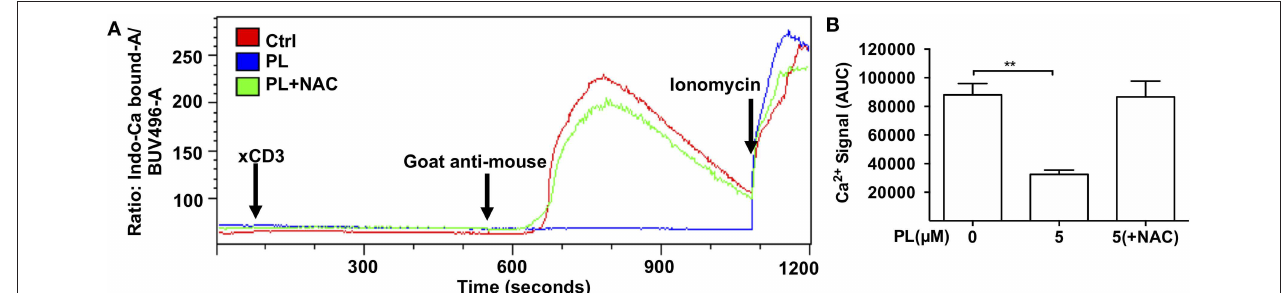
FIGURE 3 | PL inhibits TCR-mediated Ca 2 + flux. (A) Ca 2 + flux in control (red), 5 µ M PL (blue) or 5 µ M PL + NAC (green) pretreated (overnight) T cells was measured using flow cytometry. Cells were stimulated by adding CD3 antibodies (xCD3) followed by crosslinking with goat anti-mouse antibodies as indicated. Ionomycin was added as a positive control at the end of each measurement. The depicted graphs are representative for three independent experiments. (B) Quantification of Ca 2 + signal as the area under the curve (AUC) ( n = 3; mean; SEM; ** p < 0.01).